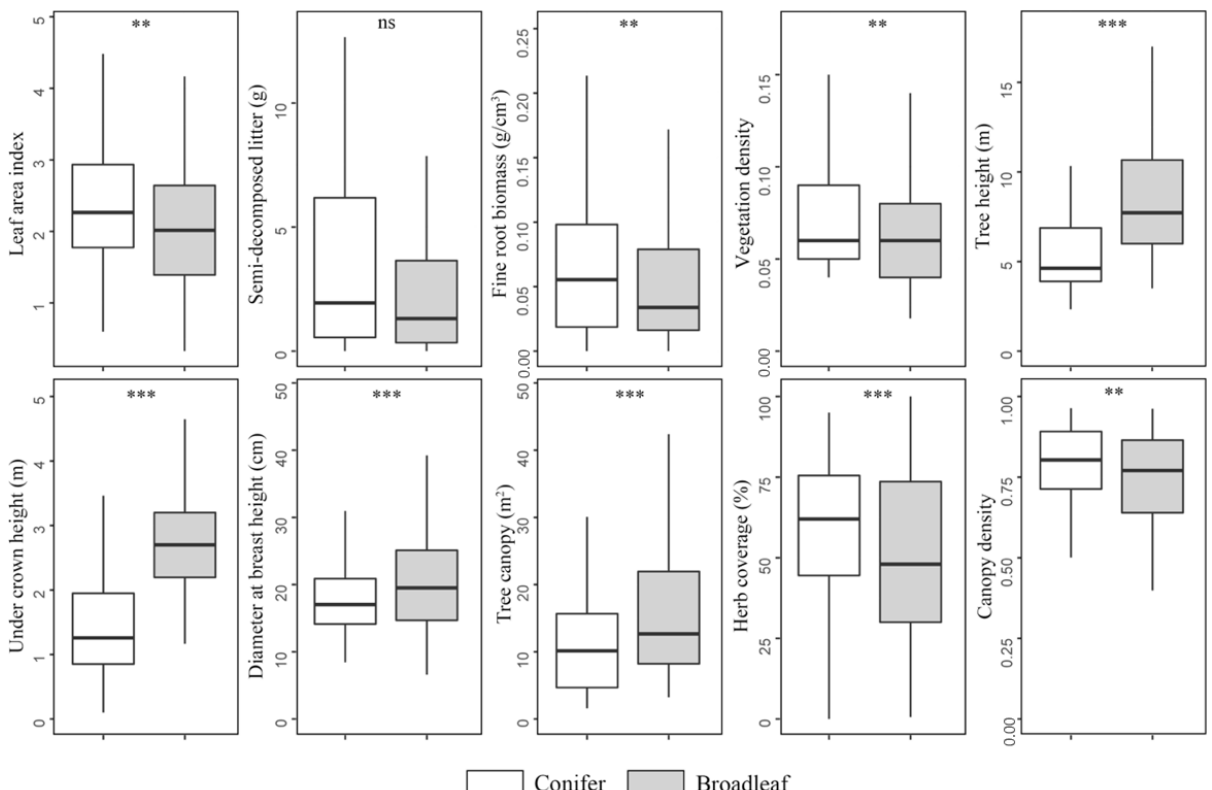
Figure 2. Forest traits compared between coniferous and broadleaved forests. Means and standard errors are shown. ** means p < 0.01, *** means p < 0.001, ns means not